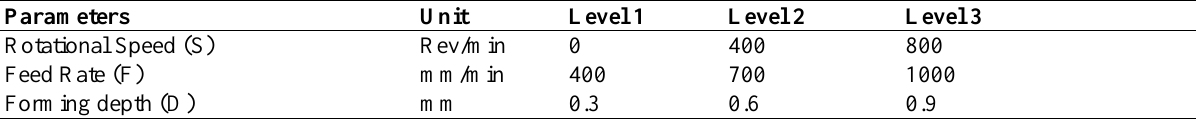
Process parameters and their levels ..“